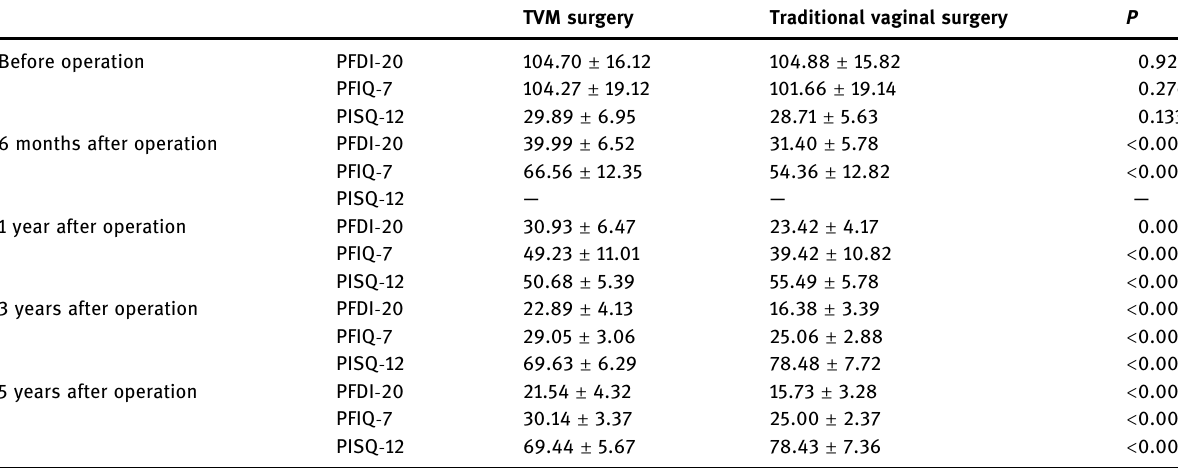
Table 2: Pre - and postoperative comparison of PFDI - 20, PFIQ - 7, and PISQ - 12 scores between the two